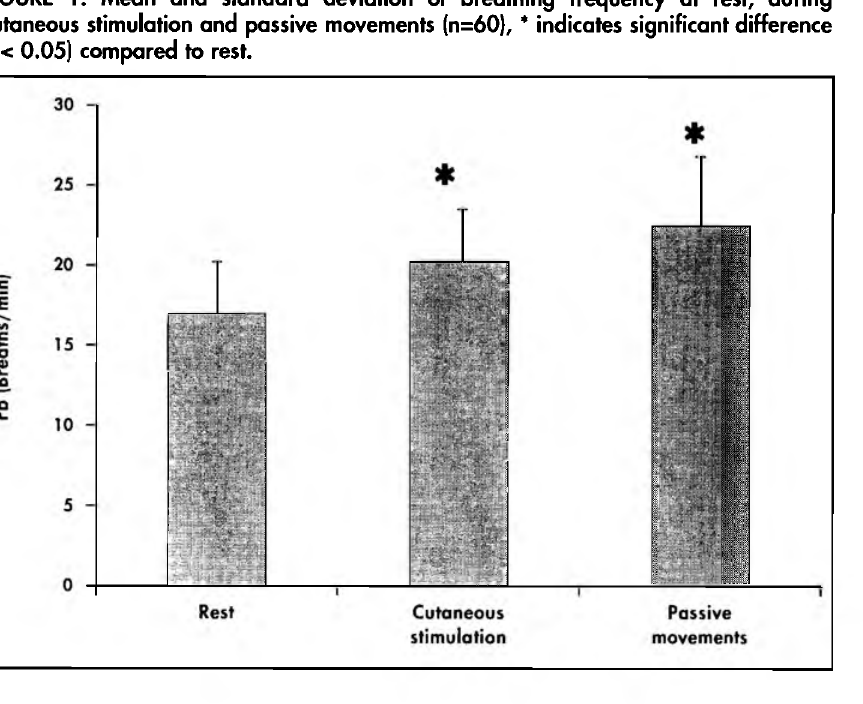
FIGURE 1. Mean and standard deviation of breathing frequency at rest, during cutaneous stimulation and passive movements (n=60), * indicates significant difference (p< 0.05) compared to rest.